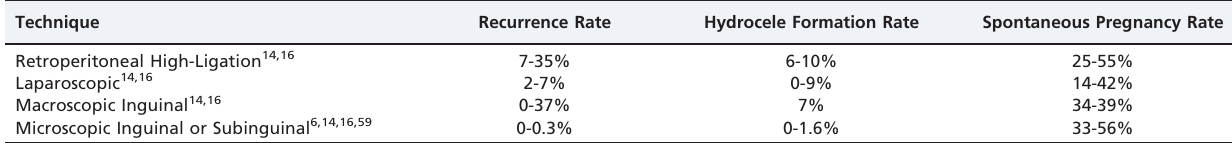
Table 1 - Treatment Results for Varicocele Repair in Infertile Men. Postoperative Recurrence, Hydrocele Formation and Spontaneous Pregnancy Rates using Various Techniques*.